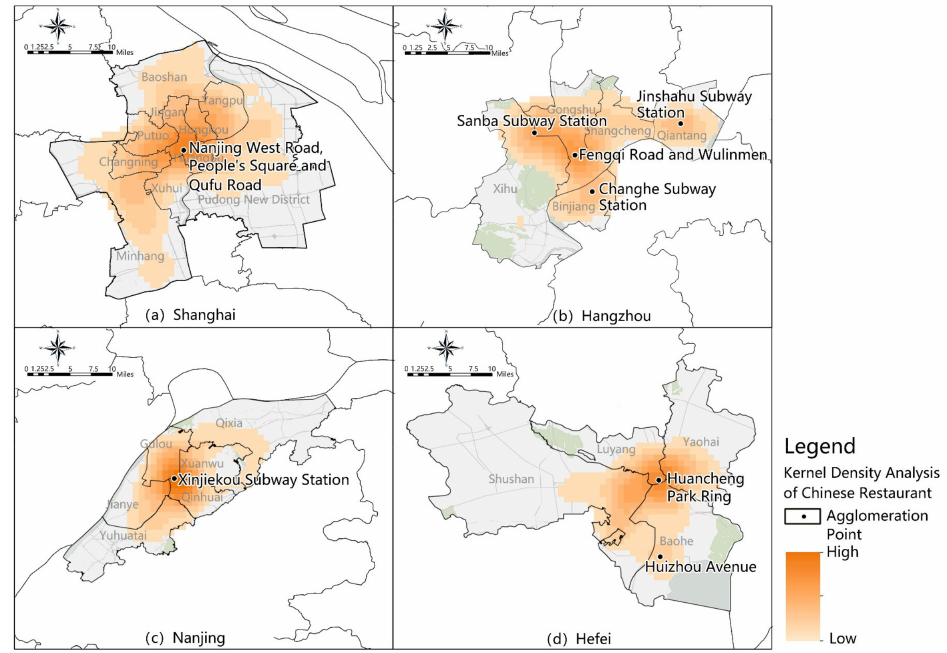
Figure 2. Kernel density analysis of Chinese restaurants in the main urban areas of the four central cities in the